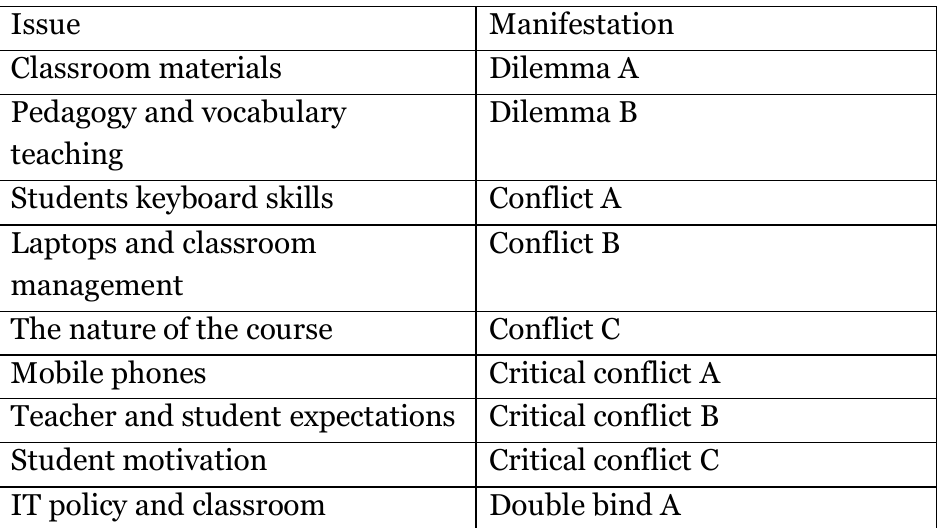
Table 6: summary of